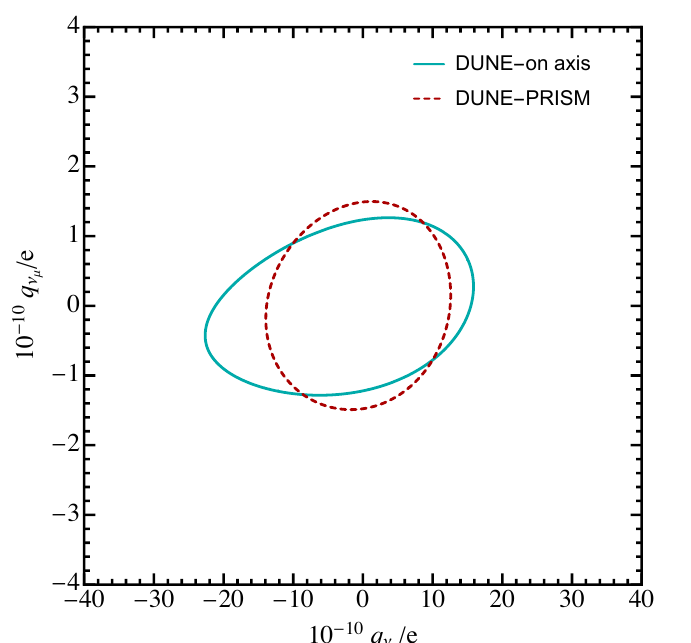
Figure 6 . Here we summarize our projected 90 % C.L. constraints from DUNE on neutrino milli- charge in both a fully on-axis scenario (solid blue) as well as an off-axis DUNE-PRISM setup (dashed